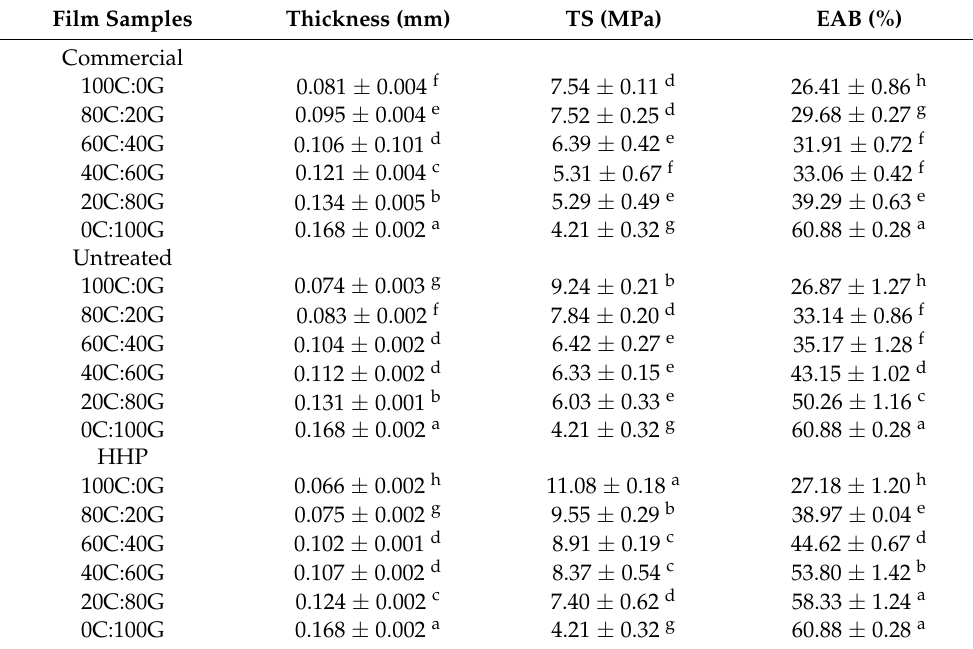
Table 1. Mechanical properties of composite